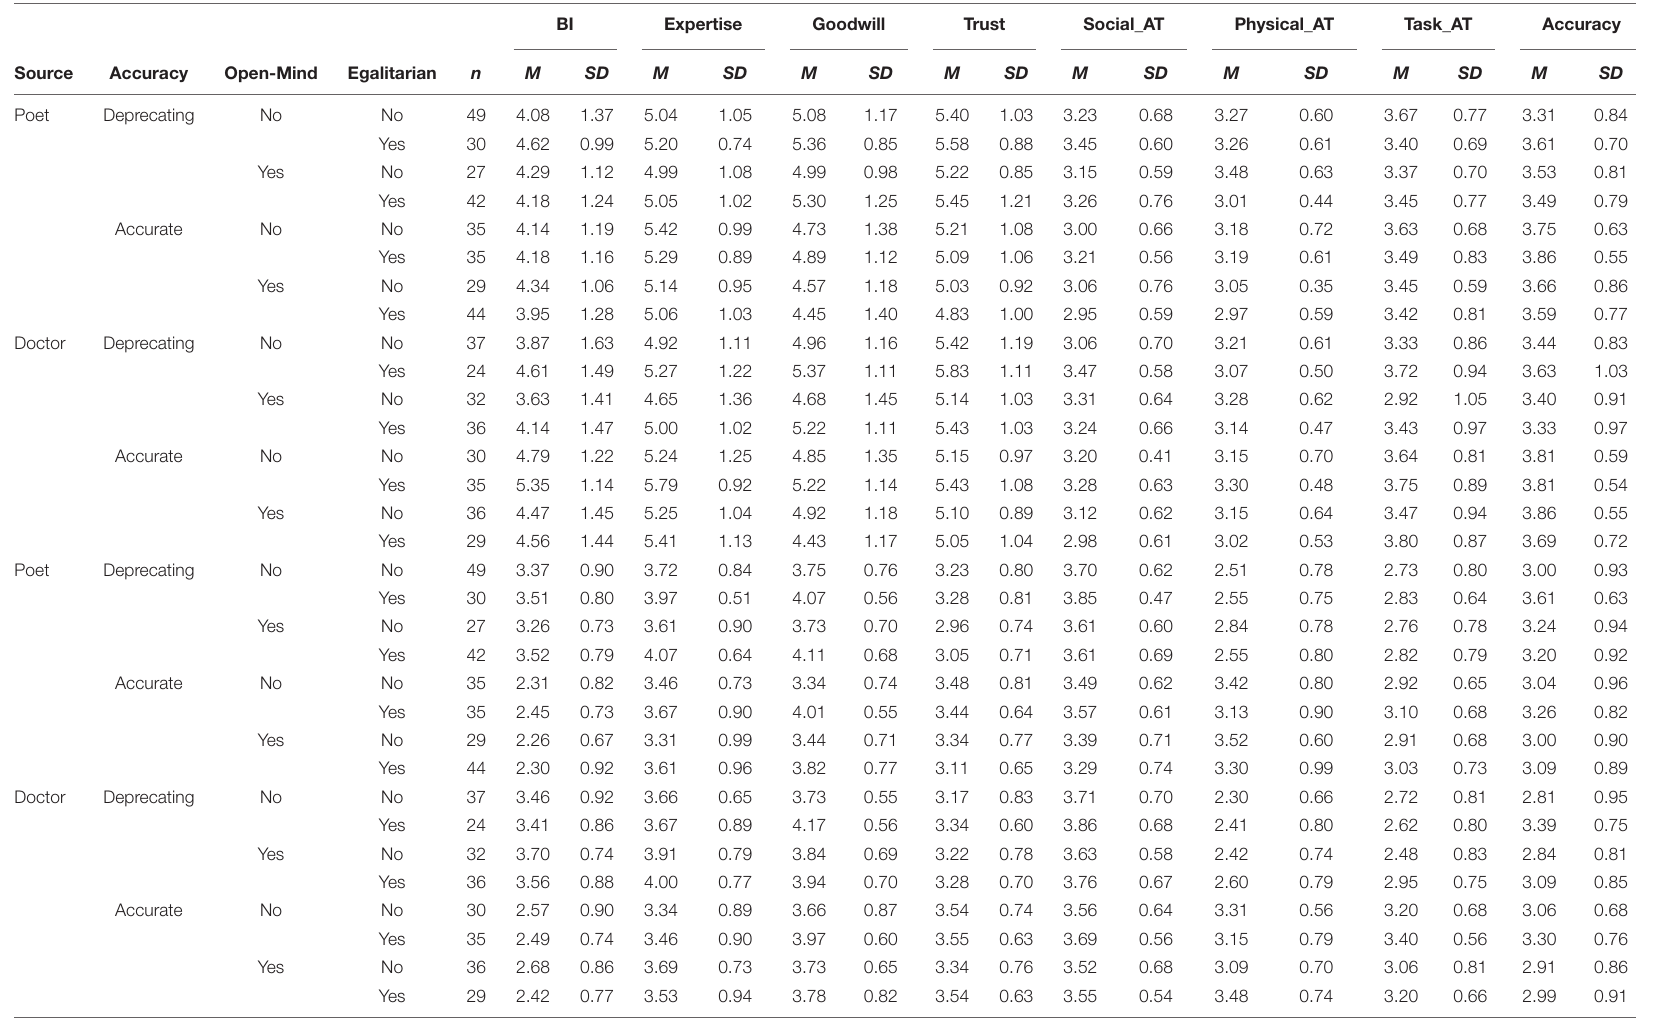
TABLE 2 | Descriptives by message condition. BI Expertise Goodwill Trust Social_AT Physical_AT Task_AT